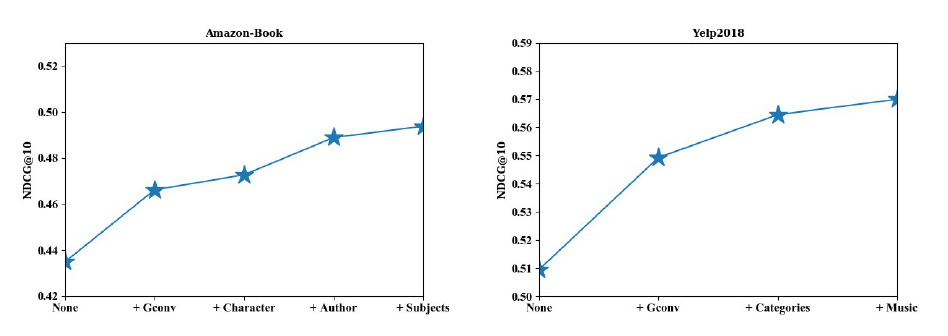
Figure 3. Recommendation performance of relevant submodels (+Gconv,+Character, +Author, +Sub- jects, +Categories, +Music) compared to that of MLP (+None) on Amazon-Book and Yelp2018 datasets by NDCG@10.